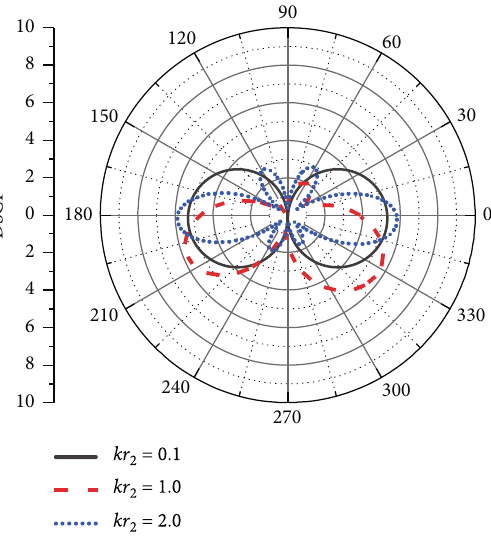
Figure 7: DSCF distribution of the circular hole at di ff erent frequencies ( d / r 2 = 5 : 0 and h / r 2 = 2 : 0